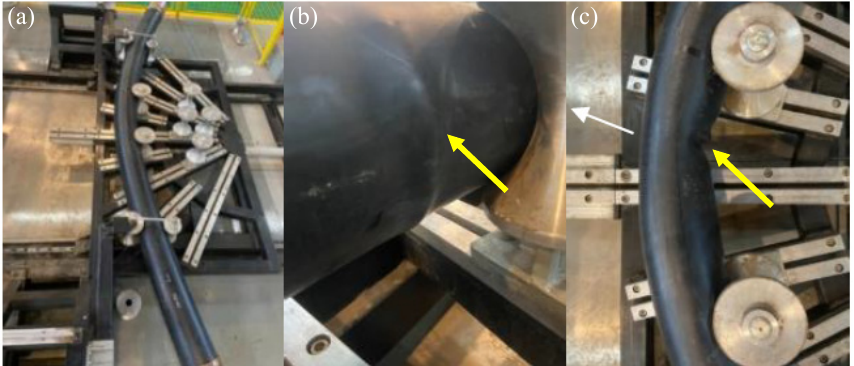
Figure 16. Bending test of the RTP sample. ( a ): bending radius of 2000 mm; ( b ): bending radius of 1100 mm; ( c ) bending radius of 1000 mm.